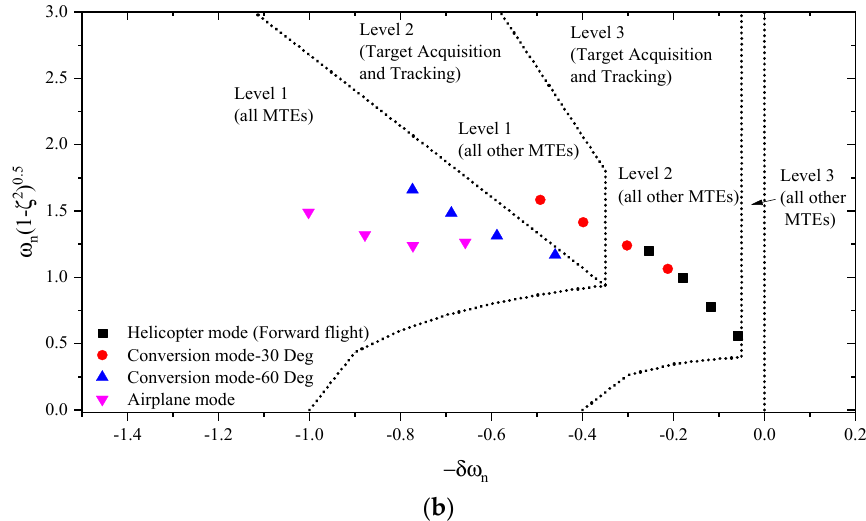
Figure 1. The eigenvalue requirements in different flight ranges. ( a ) Longitudinal requirement and lateral-directional requirement in hover and low-speed forward flight; ( b ) Lateral-direction oscillatory mode requirement.